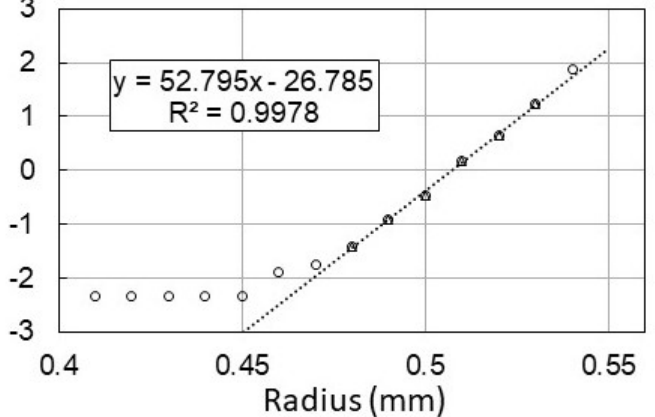
Figure 4. Normalized cumulative frequency distribution (z value on the vertical axis) of the hole radius of Specimen #3.